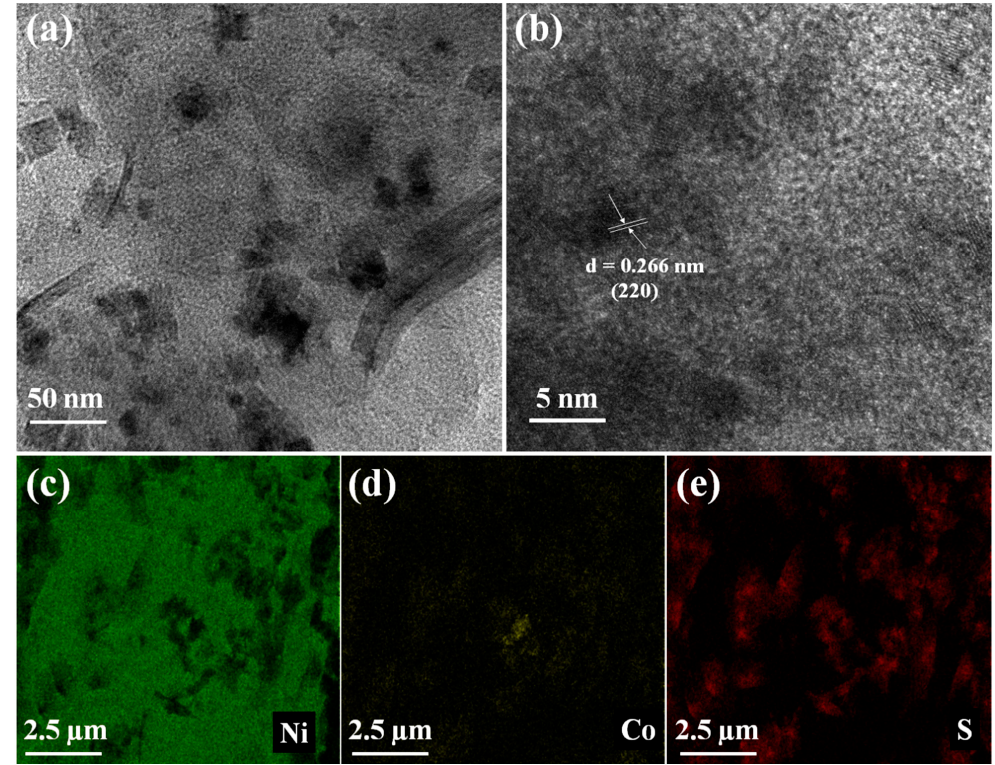
Figure 3. ( a,b ) TEM and HRTEM images, and ( c – e ) the elemental mapping images of sulfur-deficient NiCo 2 S 4 nanosheets composite.